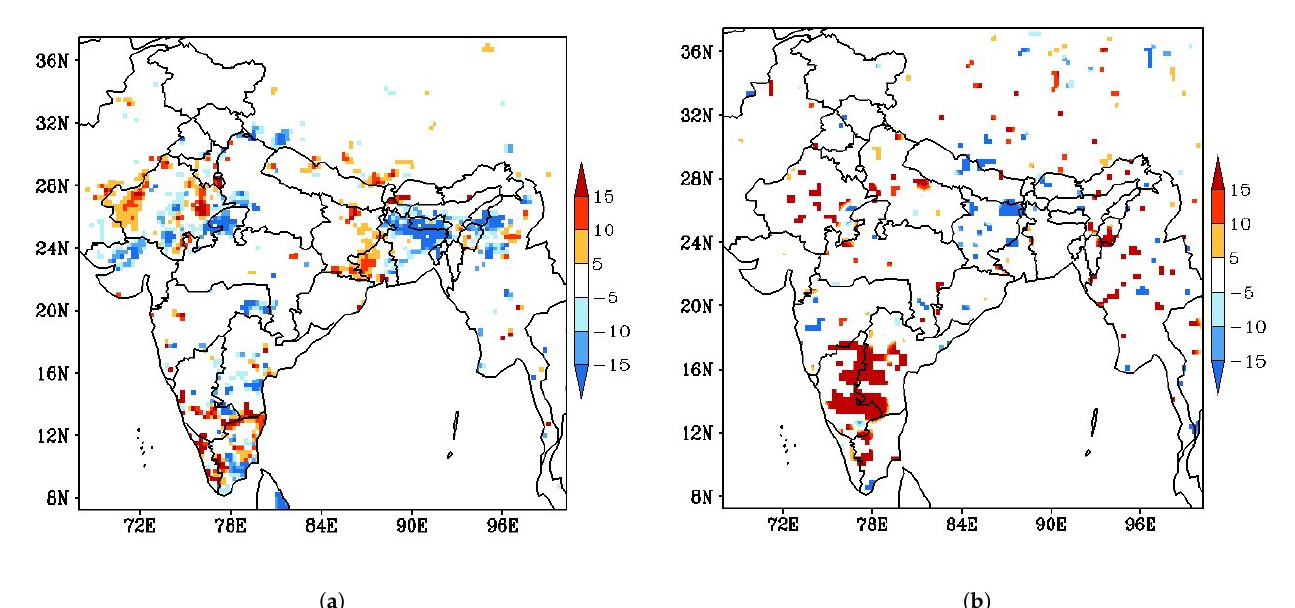
Figure 7. Map showing the percentage change in 24-h forecast error after assimilation for ( a ) (left) IWV and ( b ) (right) Surface Rainfall. Positive values correspond to decrease in RMSE (improvement in skill) and Negative values correspond to increase in RMSE (degradation in